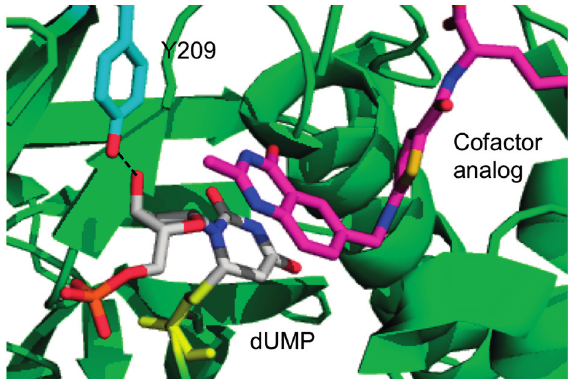
Figure 1. Active site crystal structure of the wild type (WT) ec TSase (green; PDB ID 2KCE) with 2'-deoxyuridine-5'-mono-phosphate (dUMP) (gray) and CH 2 H 4 folate analog, Raltitrexed (magenta). Tyr209 is shown in cyan. H-bond between 3'-OH of the dUMP and Tyr209 is shown in dashed lines. TSase chain is shown in cartoon representation (green). Residue Y209, the ligands dUMP and the cofactor analog, raltitrexed and the thio-ether bond between C-6 of dUMP and the C146 are in sticks. Color code for Y209: cyan (carbons), red (oxygen); Color code for dUMP: blue (nitrogen), grey (carbon), red (oxygen), orange (phosphorous); Color code for raltitrexed: blue (nitrogen), magenta (carbon), yellow (sulfur), red (oxygen), and the atoms in the thio-ether bond are shown in